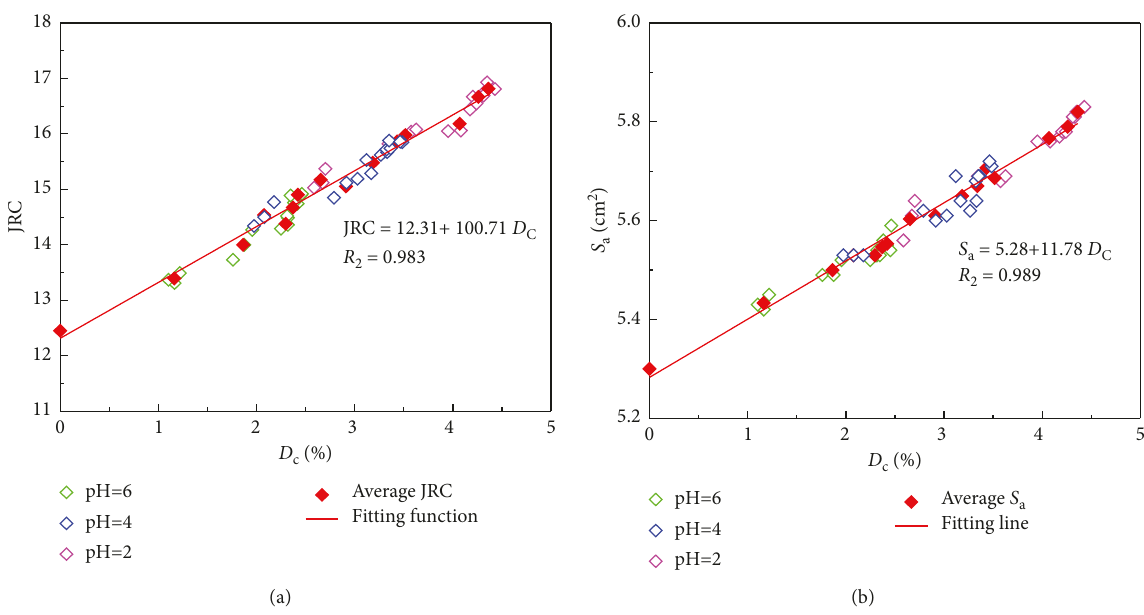
Figure 12: Variations in morphology of the fracture surface versus dynamic damage variable: (a) JRC, (b) the actual